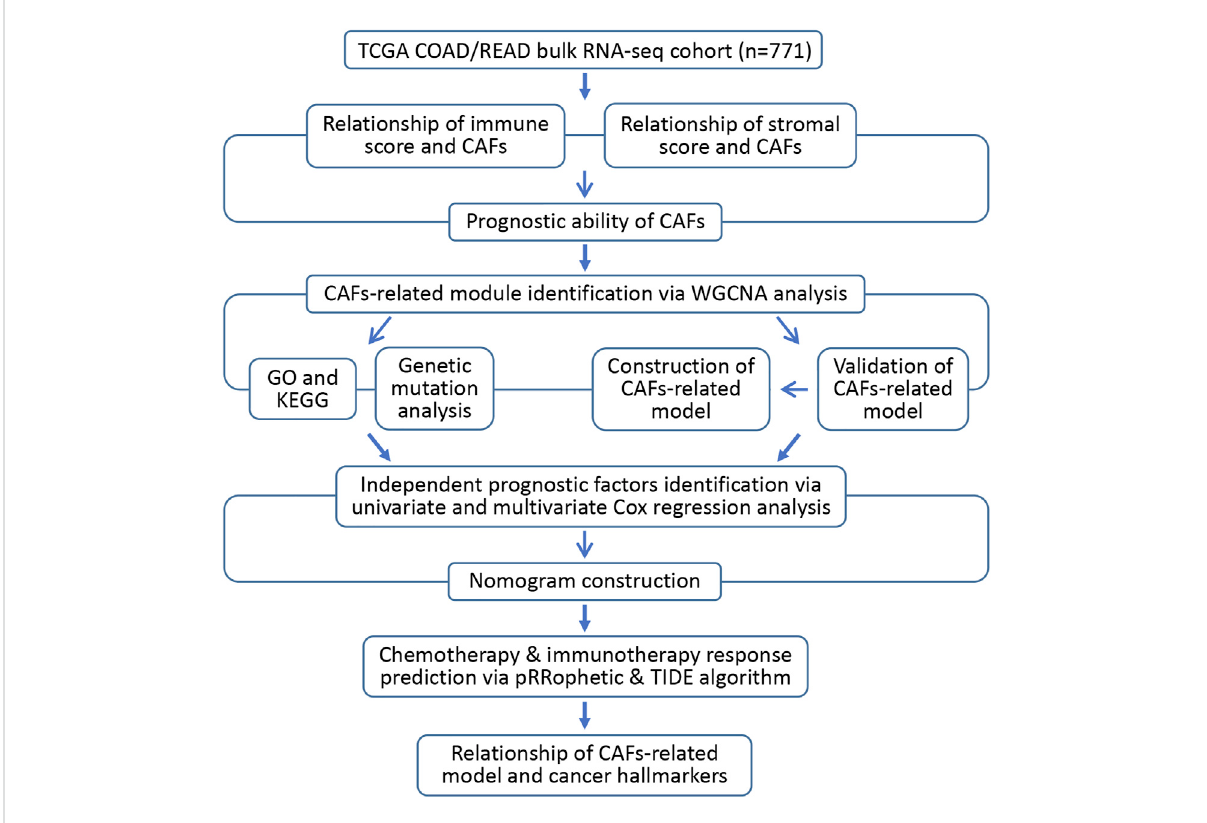
FIGURE 1 Flow diagram of the current